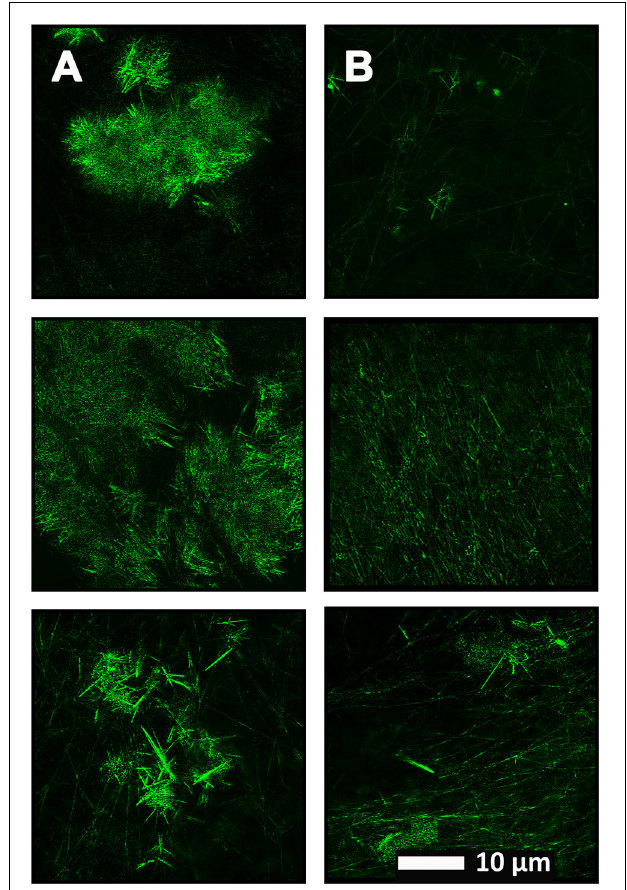
FIGURE 5 | (A) Naïve clot structure from representative Alzheimer-type dementia individuals as seen with Airyscan super-resolution confocal microscopy. PPP from each individual was incubated with the fluorescent marker ThT. PPP were mixed with thrombin to create an extensive fibrin network. (B) Micrograph of the PPP clots from the same individual in the opposite column (A) , after treatment with LBP, followed by addition of ThT and clot